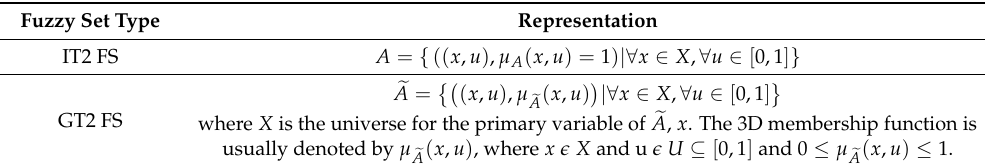
Table 1. Interval type-2 (IT2) and generalized type-2 (GT2) fuzzy set (FS) representation.